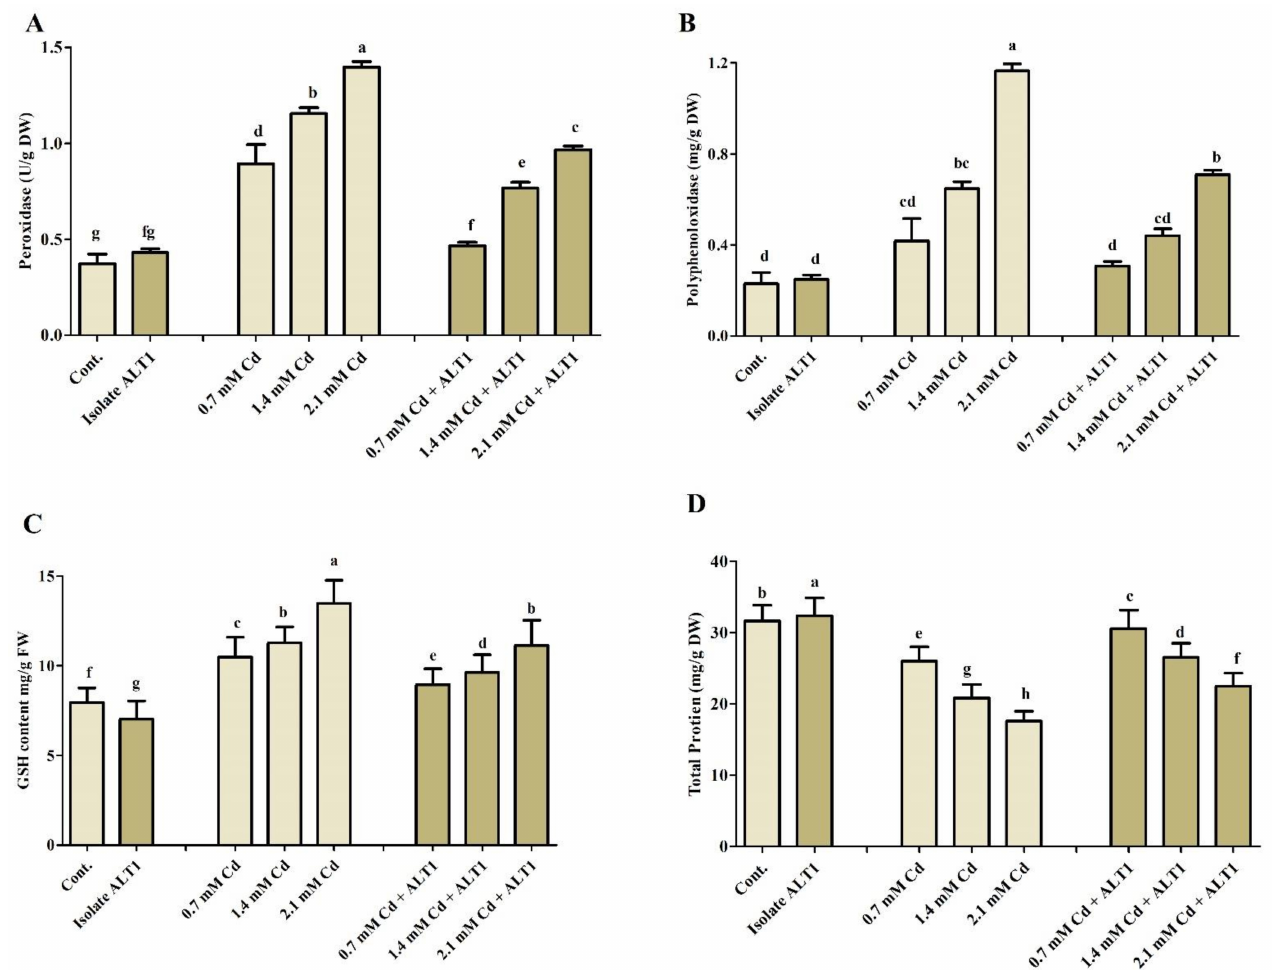
Figure 5. The effect of Cd stress on different antioxidant components of ALT1-inoculated and non-inoculated soybean plants. ( A ) POD (peroxidase); ( B ) PPO (polyphenol oxidase); ( C ) GSH (reduced glutathione); and ( D ) TP (total protein) contents in soybean plants grown under normal conditions and under Cd stress. Each data point is the mean of three replicates. Error bars represent standard errors. The bars presented with different letters are significantly different from each other as evaluated by Duncan’s multiple range